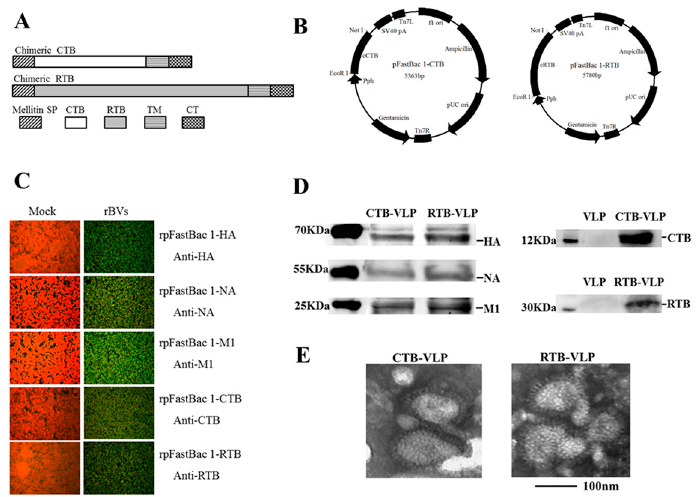
Figure 1. Construction and characterization of cVLPs containing membrane-anchored CTB or RTB.